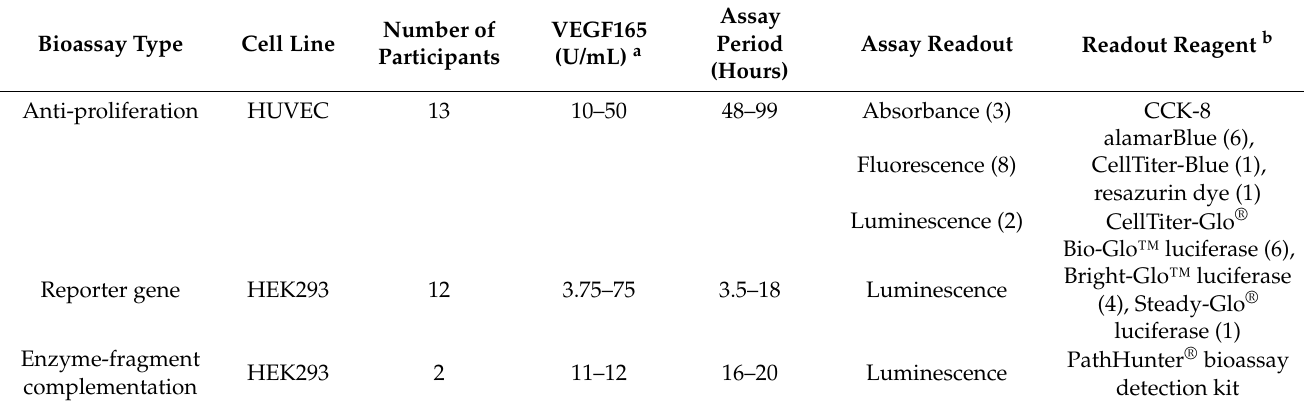
Table 4. Summary of VEGF165 neutralisation assays contributing to the study.